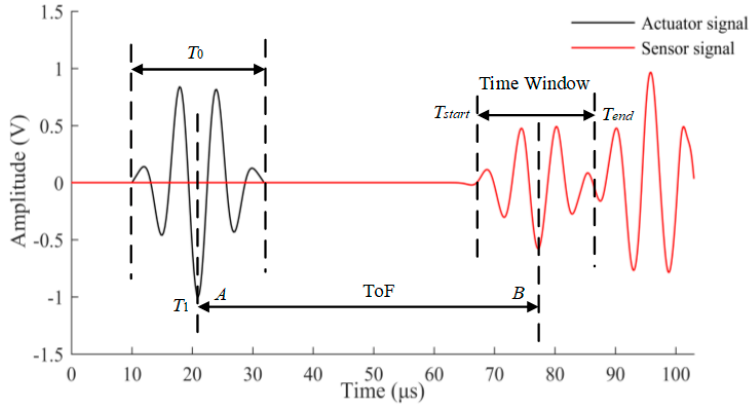
Figure 4. Illustration of the time window calculation of Lamb wave response data.